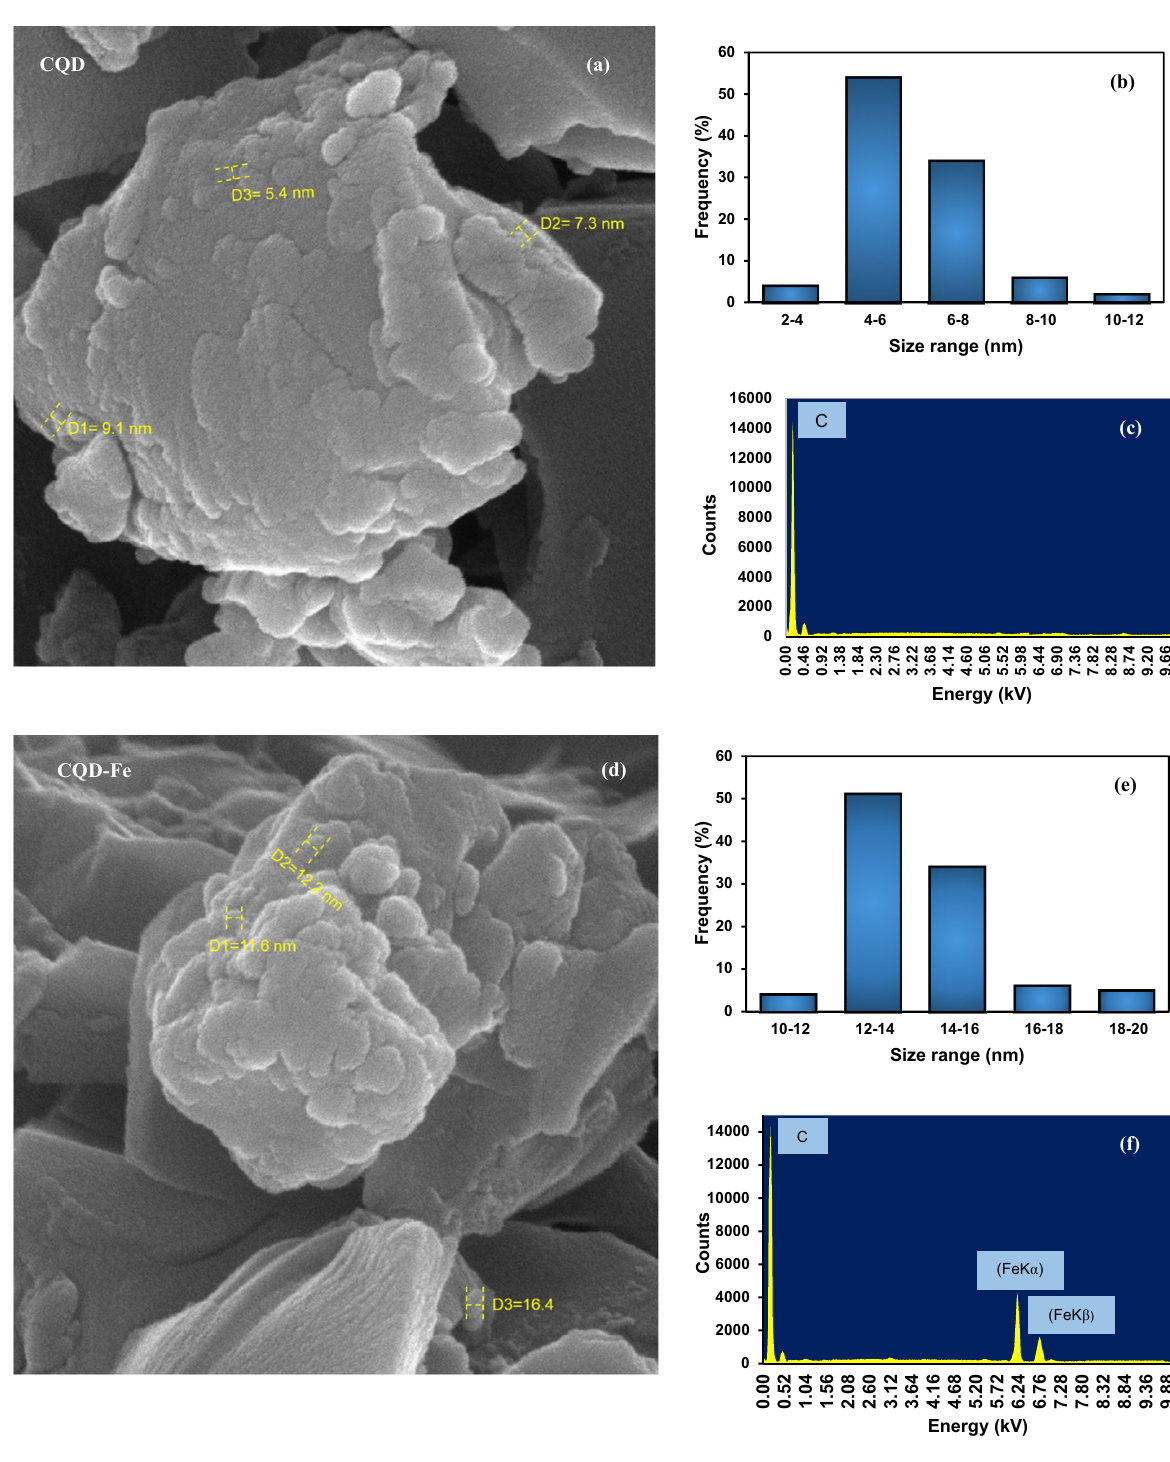
Figure 6. SEM image, particle size distribution and EXD analysis for CQD ( a–c ), and for CQD-Fe ( d–f ).